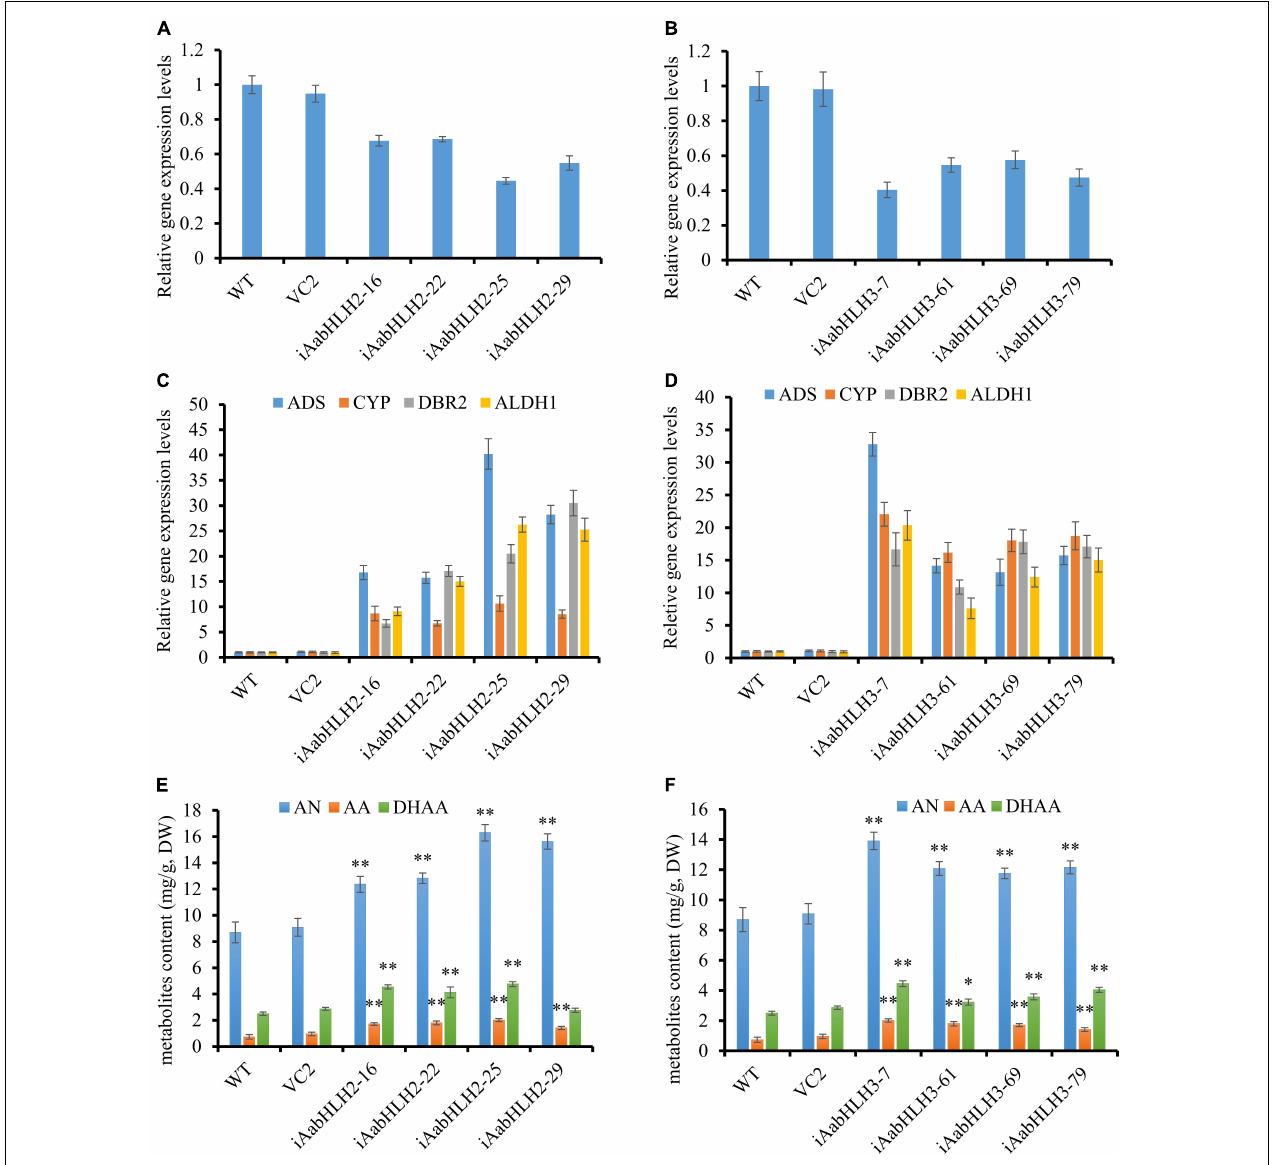
FIGURE 4 | RNA interference reducing AabHLH2 and AabHLH3 gene expression affects artemisinin biosynthetic pathway gene expression levels and artemisinin-related metabolites contents. (A) Gene expression analysis of AabHLH2 in the AabHLH2 RNAi transgenic plants. (B) Gene expression analysis of AabHLH3 in the AabHLH3 RNAi transgenic plants. (C) Relative gene expression of ADS , CYP71AV1 , DBR2, and ALDH1 in the AabHLH2 RNAi transgenic plants. (D) Relative gene expression of ADS , CYP71AV1 , DBR2, and ALDH1 in the AabHLH3 RNAi transgenic plants. (E) The contents of artemisinin (AN), dihydroartemisinic acid (DHAA), and artemisinic acid (AA) in the AabHLH2 RNAi plants and wild-type plants were determined by HPLC analysis. (F) The contents of artemisinin (AN), dihydroartemisinic acid (DHAA), and artemisinic acid (AA) in the AabHLH3 RNAi plants and wild-type plants were determined by HPLC analysis. The metabolites contents in the transgenic plant leaves were compared to the wild-type plants. Asterisks indicate the difference between RNAi transgenic plants and wild-type plants. Statistical significance was determined by Student’s t -test: ∗∗ , P < 0.01; ∗ , P <